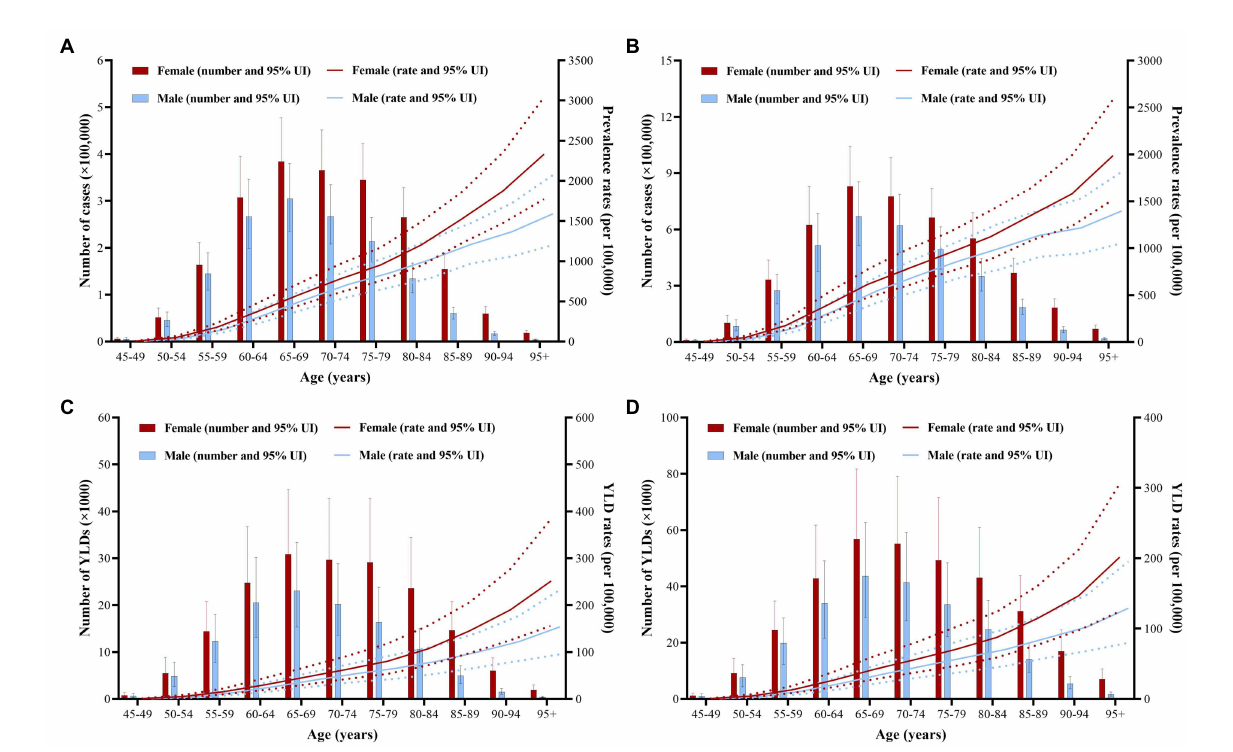
FIGURE 2 Global burden of the prevalence and YLDs of AMD by age and sex in 1990 and 2019. (A) The number of cases and crude prevalence rates of AMD in 1990. (B) The number of cases and crude prevalence rates of AMD in 2019. (C) The number of YLDs and crude YLD rates of AMD in 1990. (D) The number of YLDs and crude YLD rates of AMD in 2019. Red and blue dashed line indicates the upper and lower limits of the 95% uncertainty intervals (95% UIs) for females and males, respectively. AMD, age-related macular degeneration; UI, uncertainty interval; YLDs, years lived with